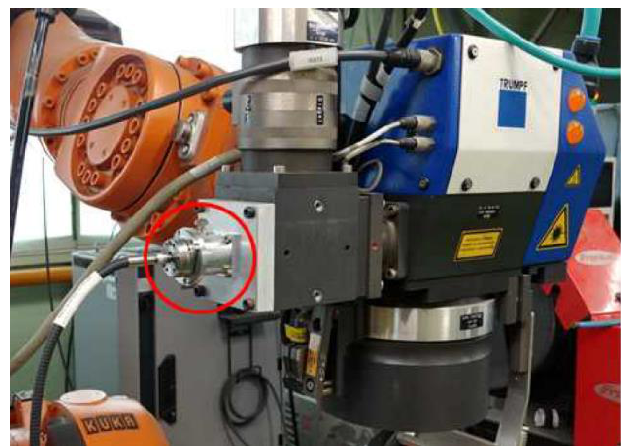
Figure 3. Experimental setup and installation of the spectrometer.